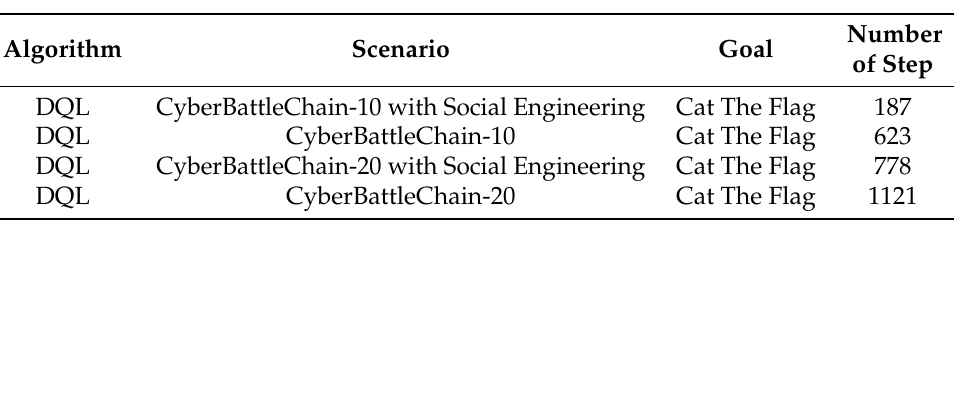
Table 5. Specific values of experimental results in Figure